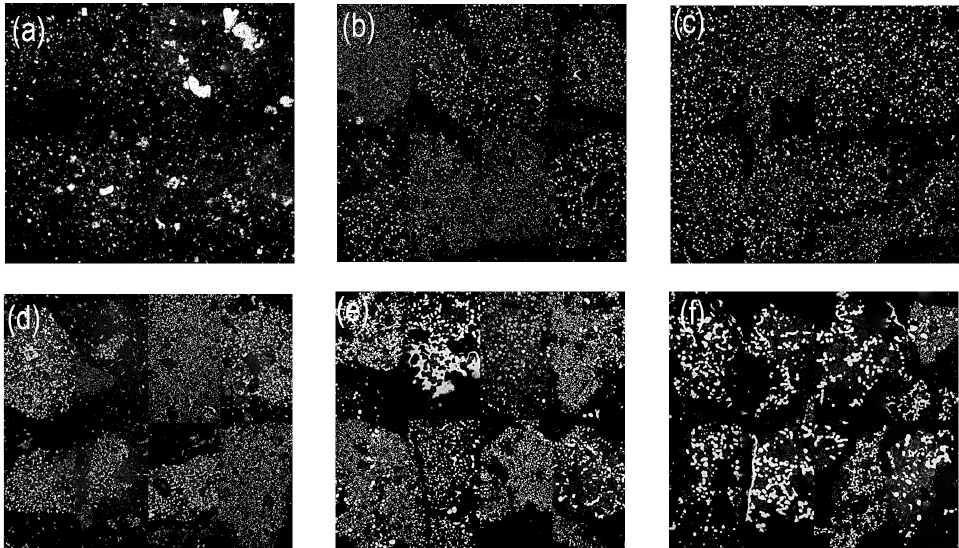
Figure 9. The microstructure of the roasted samples without additives obtained after carbothermic reduction at 1000 °C ( a – c ) and 1200 °C ( d – f ) for 5, 15 and 30 min, respectively (×250 magnification).